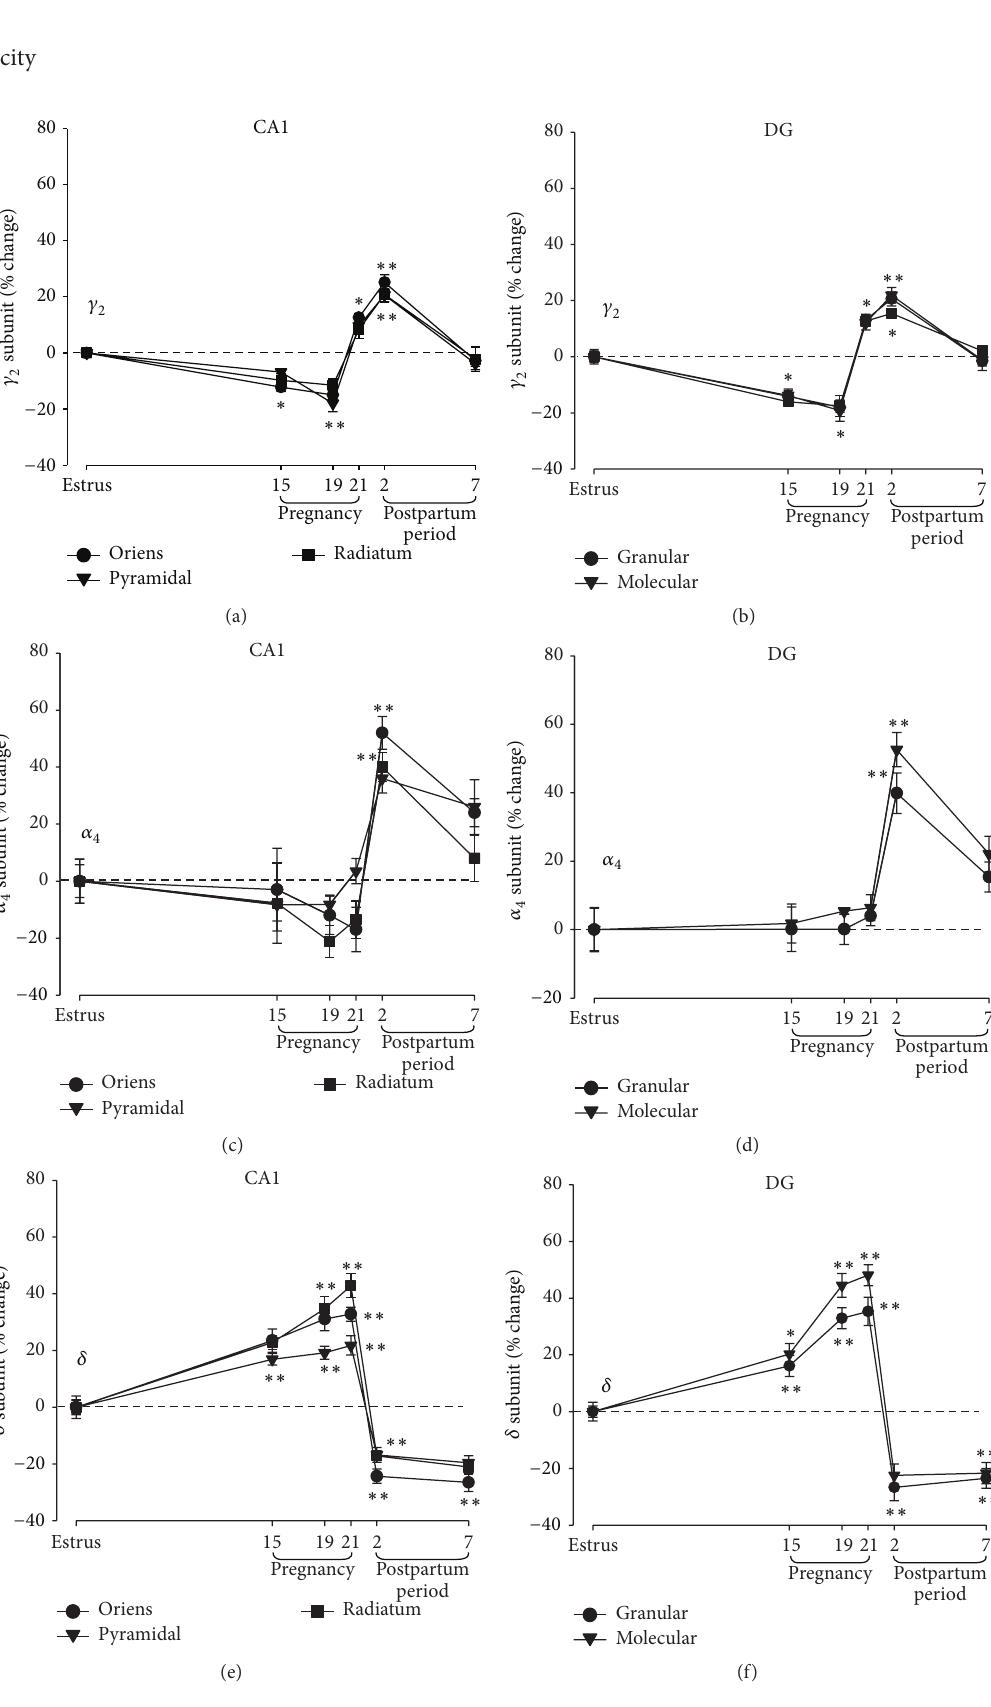
Figure 1: Changes in immunoreactivity for different subunits of the GABAAR in the rat hippocampus during pregnancy and after delivery. Scatter plot relative to immunoreactivity quantification of different GABAAR subunits ( 𝛾 2, 𝛼 4, and 𝛿 ) evaluated in the hippocampal CA1 subregion (left panels) and dentate gyrus (right panels) during pregnancy and after delivery. Adapted from Sanna et al., 2009